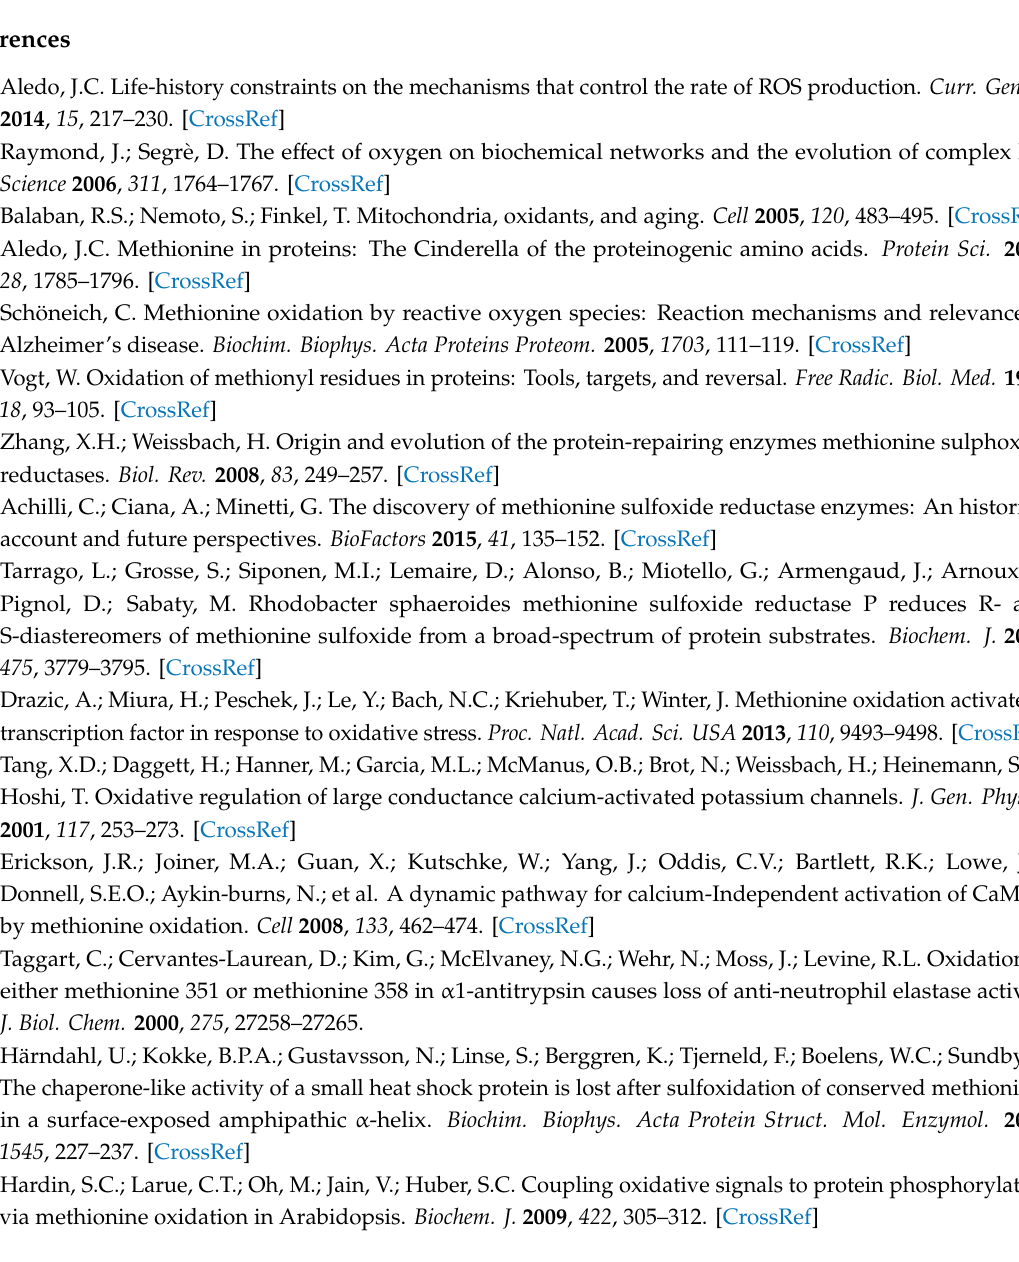
Figure S1: Overrepresentation of acidic residues in the sequence environment of MetO oxidized in vivo in Arabidopsis thaliana . Figure S2: Sequence environment analyses within the cytosolic subset of ex vivo oxidized proteins. Table S1: References related to the proteomic studies describing the MetO sites used in the current work. Table S2: Subcellular clusters containing at least 10 proteins from the dataset. Code and raw data can also be obtained at https: // bitbucket.org / jcaledo /